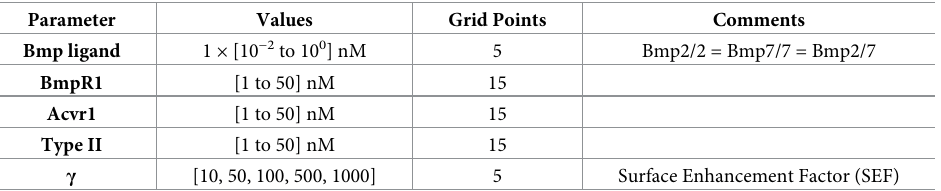
Table 1. 84,375 Point Parameter